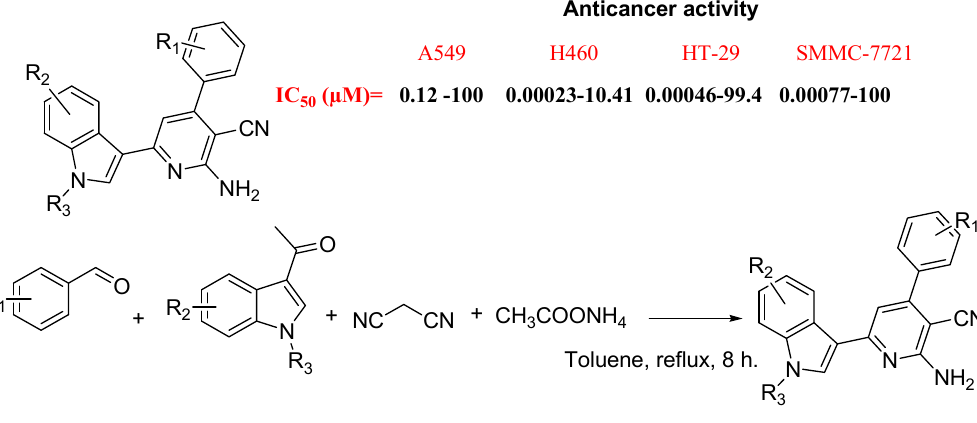
Figure 32. 2-Amino-3-cyano-6-(1 H -indol-3-yl)-4-phenylpyridine derivatives